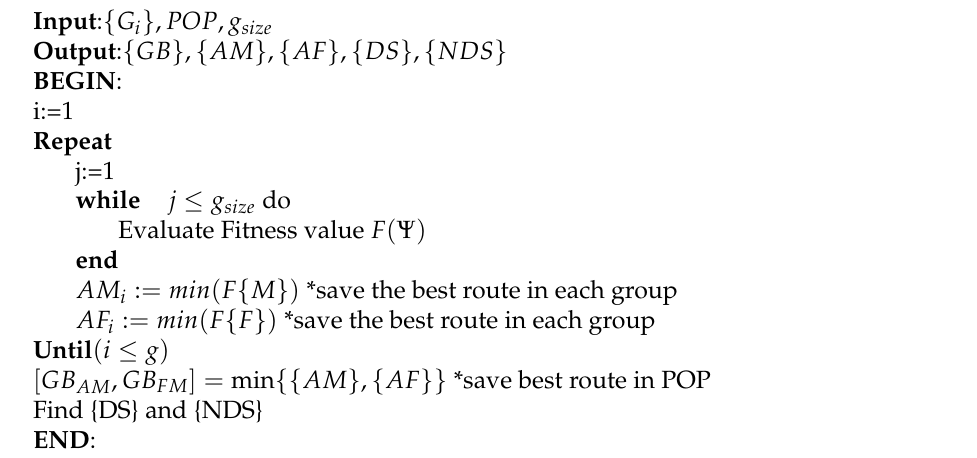
Algorithm 2 Classification of